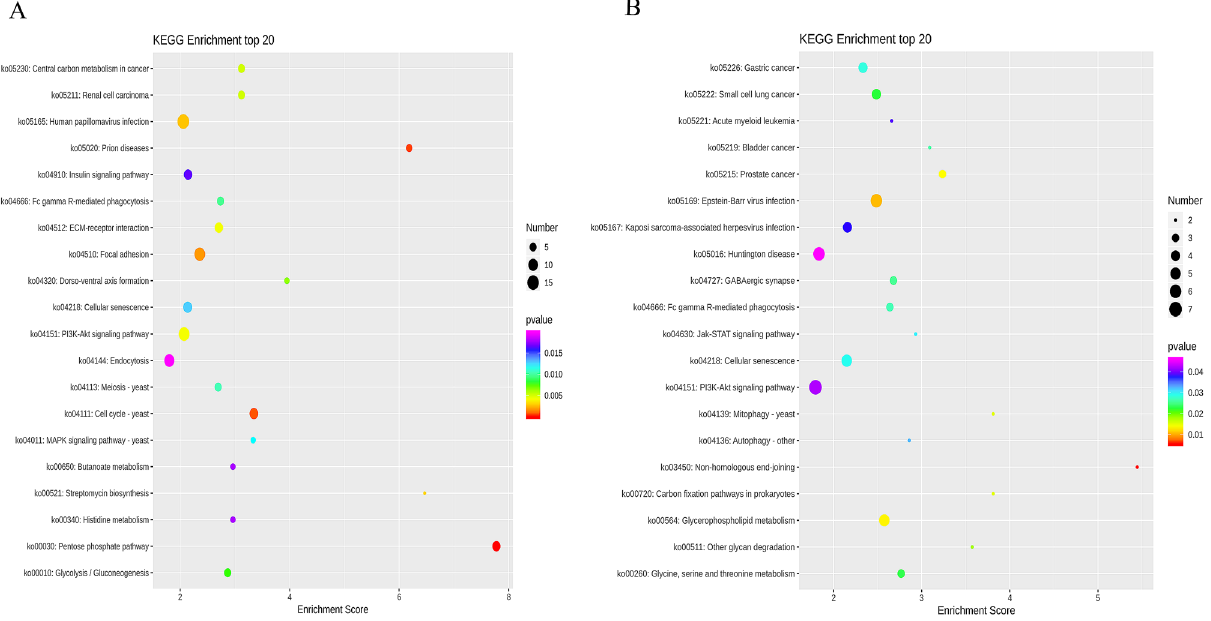
Figure 7. Bubble map of KEGG top 20 differentially methylated genes in CCGG sites ( A ) and CCWGG sites ( B ).